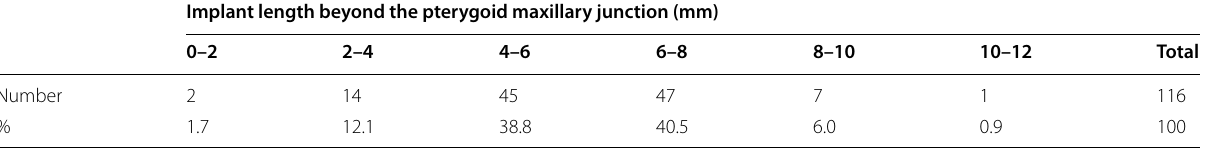
Table 2 Implant length beyond the pterygoid maxillary